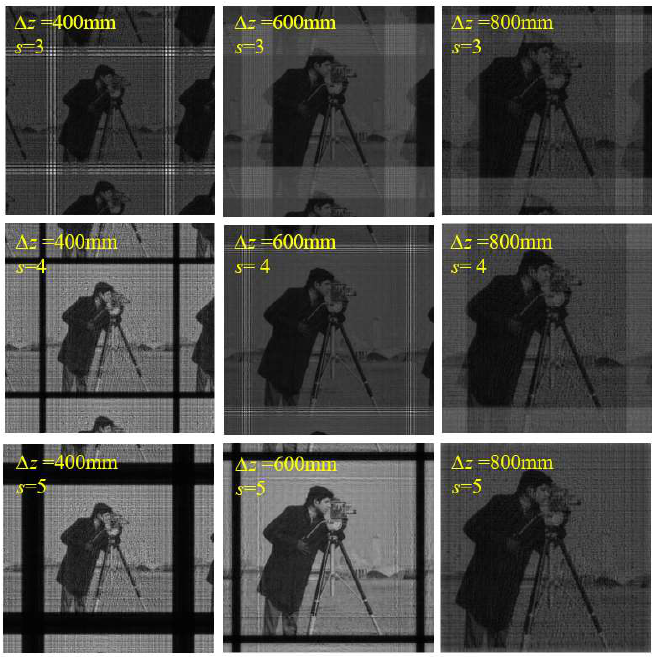
Figure 11. Calculated amplitude distributions on diffraction plane with different ∆ z and different s using MPASM.